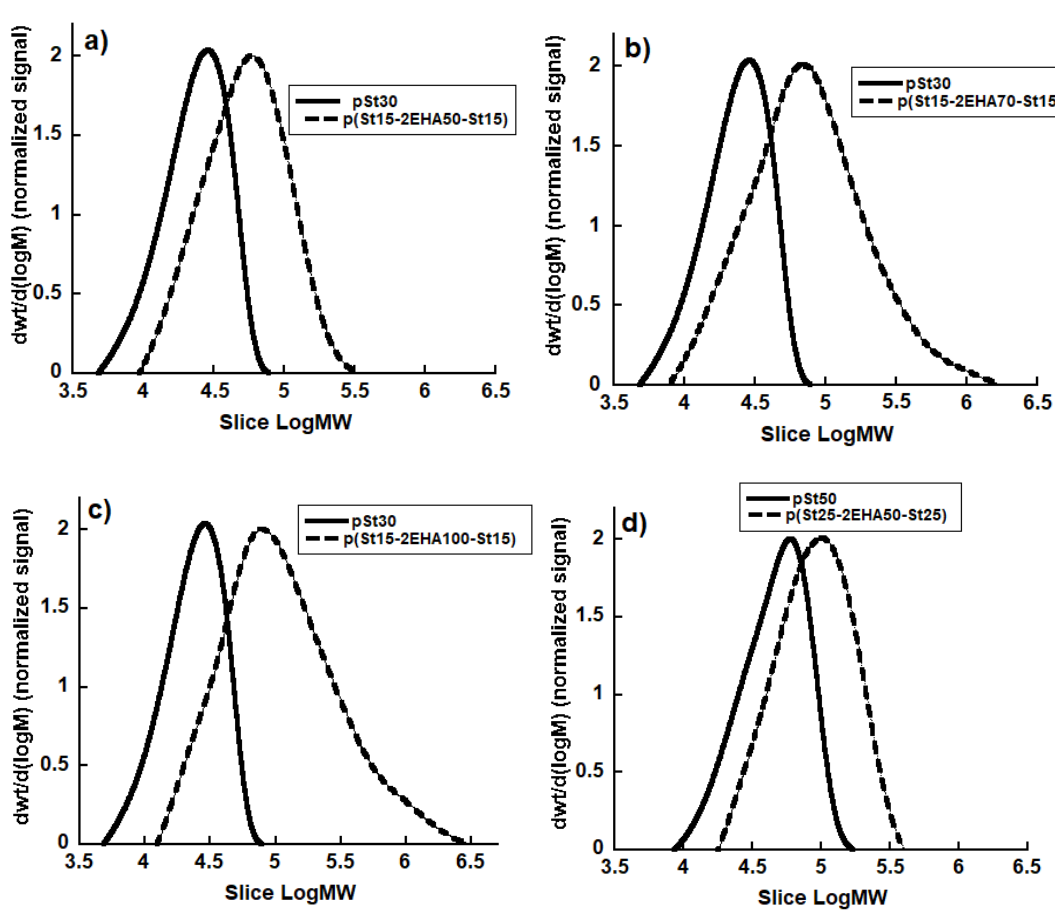
Figure 5. MWD of the initial pSt homopolymer (solid line) and final block copolymers (dashed line) of different pSt-EHA-St compositions.